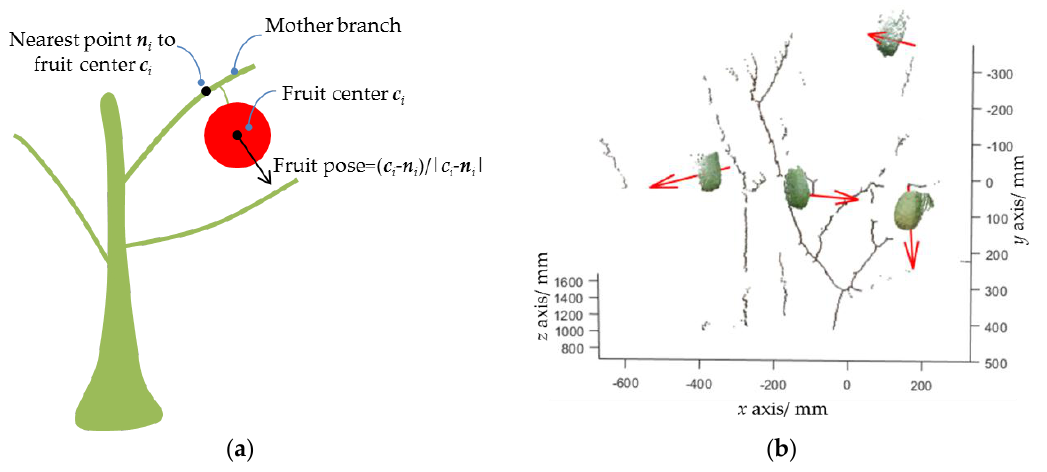
Figure 7. Principle of fruit pose estimation. ( a ) Schematic diagram; ( b ) three-dimensional (3D) pose estimation result, where the red array represents the fruit pose.